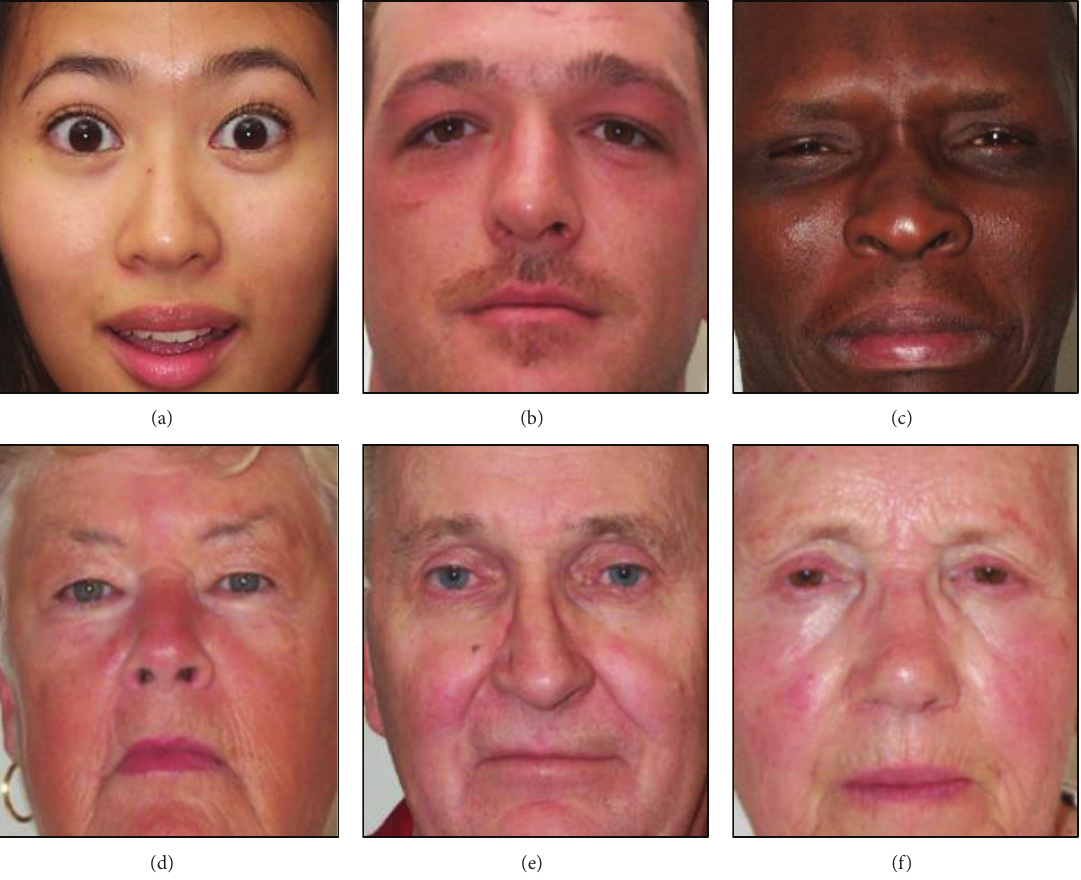
Figure 13: Examples of estimated and ground-truth ages: (a) ground-truth age of 19, estimated age of 19, (b) ground-truth age of 32, estimated age of 31, (c) ground-truth age of 41, estimated age of 40, (d) ground-truth age of 65, estimated age of 65, (e) ground-truth age of 72, estimated age of 72, and (f) ground-truth age of 81, estimated age of 80.